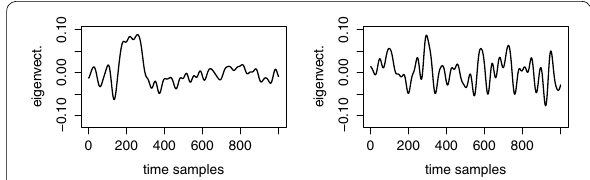
Fig. 4 Exemplary standard deviation traces for different tag values corresponding to User 8, Electrode P7 (left) and User 6, Electrode P7 (right)